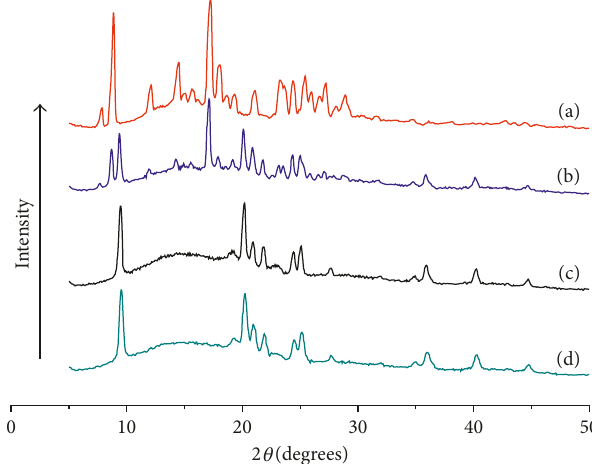
Figure 5: XRD patterns of free Cur (a), physical mixture of PMs and Cur (b), Cur-TPGS-PMs (c), and void PMs